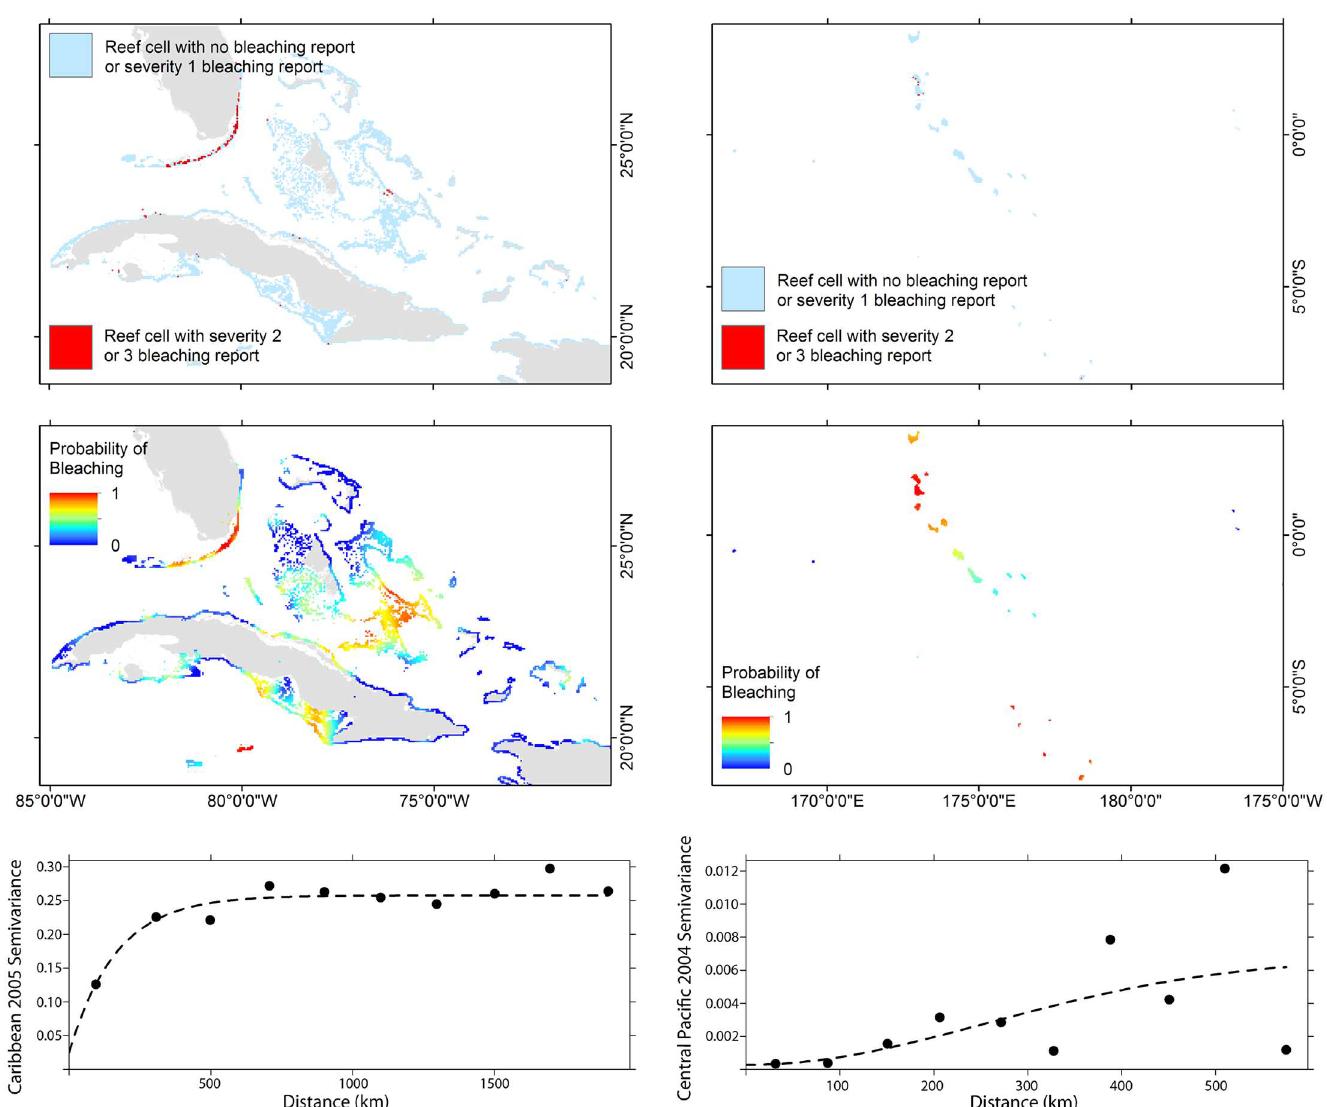
Fig 4. Examples of bleaching observations and probabilities for the Caribbean in 2005 (a,c,e) and central-westequatorial Pacific in 2004 (b,d,f). Top panels(a,b) show the raw observations of moderate and severe bleaching(level2 and 3) from the database; middle panels(c,d) show the interpolated bleachingprobabilities; and bottom panels (e,f) show the semi-variogramsfor the regionand year.